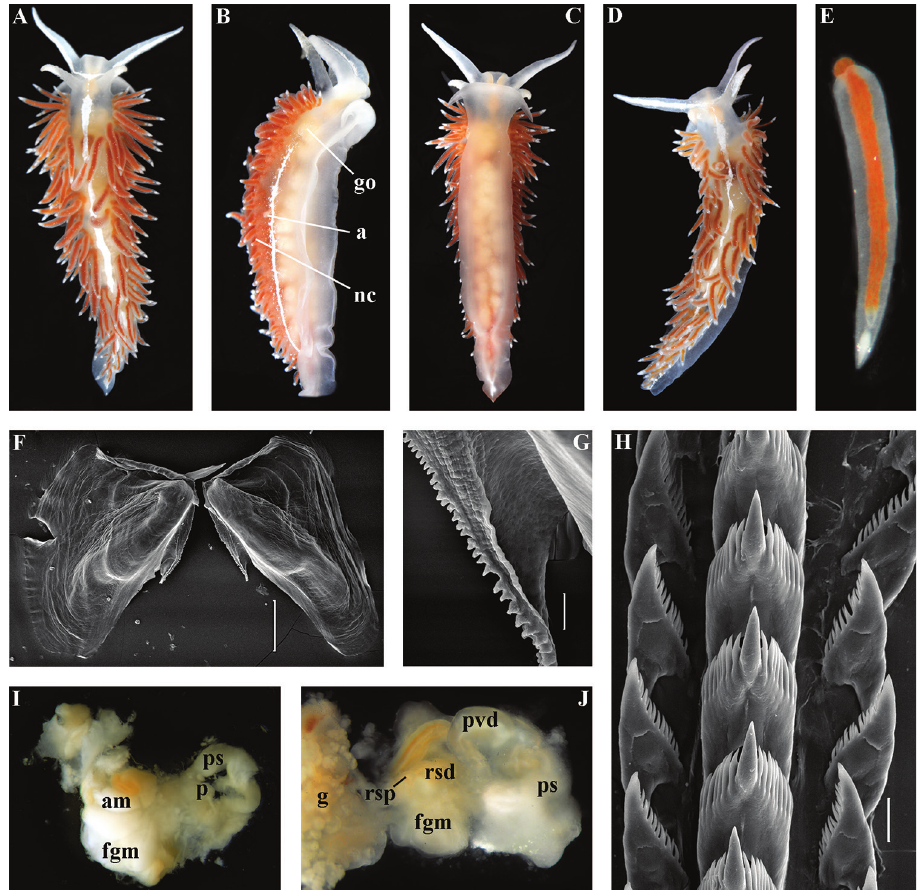
Figure 26. Gulenia monicae sp. n. Norwegian Sea, Gulen Dive Center. Holotype ZMMU Op-466, living specimen 34 mm length: A dorsal view B lateral view C ventral view; Paratype ZMMU Op-411, living specimen 24.5 mm length D dorsal view E details of cerata F jaw, SEM G details of masticatory process of jaw, SEM H radular teeth, posterior part, SEM I J reproductive system, light microscopy. Abbrevia- tions: a anus am ampulla fgm female gland mass g gonad go genital opening nc continuous notal edge p penis ps penial sheath pvd prostatic vas deferens rsd distal receptaculum seminis rsp proximal recep- taculum seminis. Scale bars: F = 300 μm; G, H = 30 μm. Photos and SEM images by T.A. Korshunova, A.V.